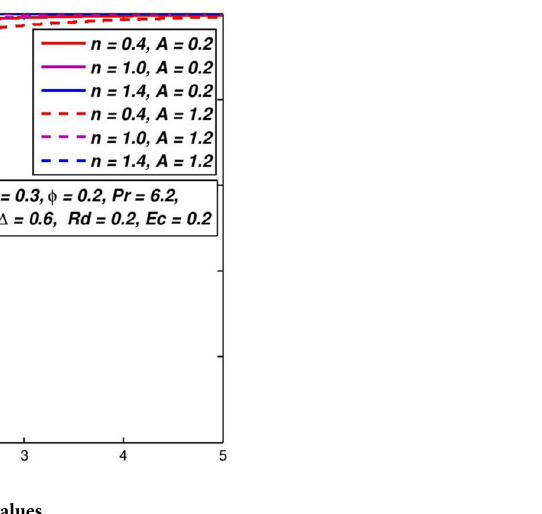
Fig 4. Effect of A on f 0 ( η ) for diverse n